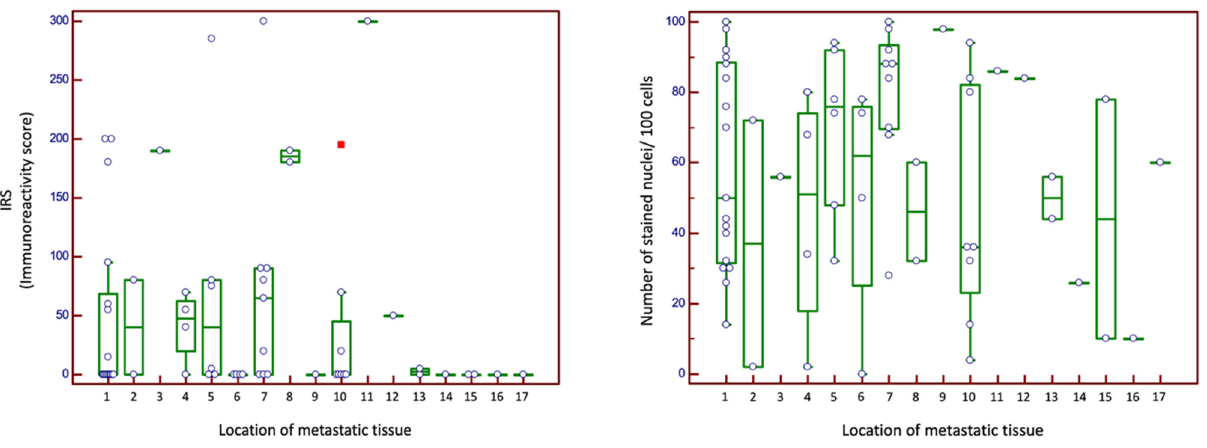
Figure 3. Cytoplasmic and nuclear expression scores for cohort n 3 (metastatic tissue cohort). 1 lung; 2 liver; 3 pleura; 4 adrenal gland; 5 lymph node; 6 pancreas; 7 soft tissue; 8 skin; 9 larynx; 10 bone; 11 local recurrence; 12 sympathetic trunk; 13 diaphragm; 14 mesentery; 15 small intestine; 16 spleen; 17 peritoneum. Abbreviations: IRS: immunoreactivity score. Green box represents median and 1st and 3rd quartile. Purple circles are individual values, circles outside the box are outside values. Red squares are far out values.